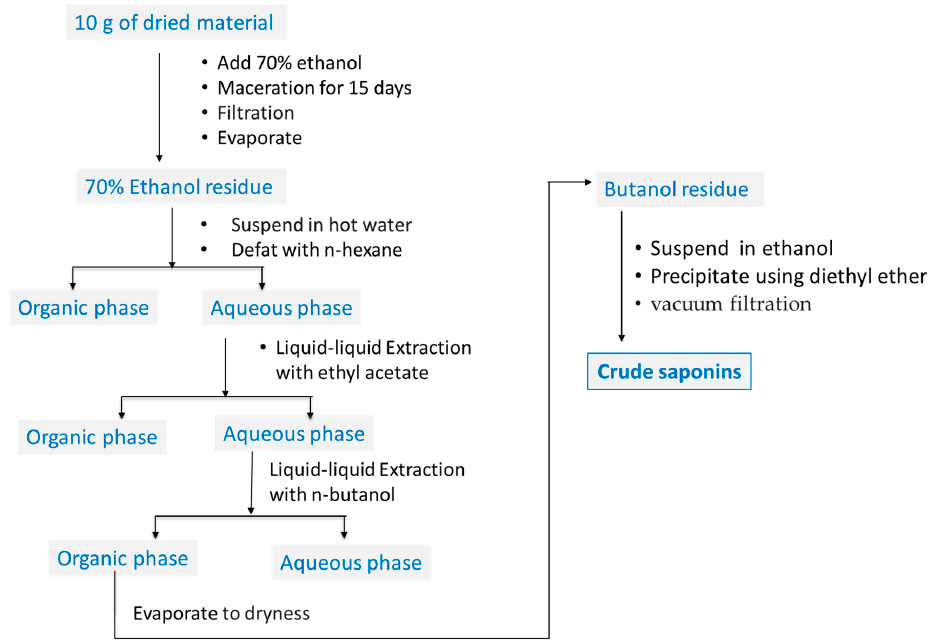
Figure 6. Schematic diagram of extraction procedure of saponins-rich argan sample.